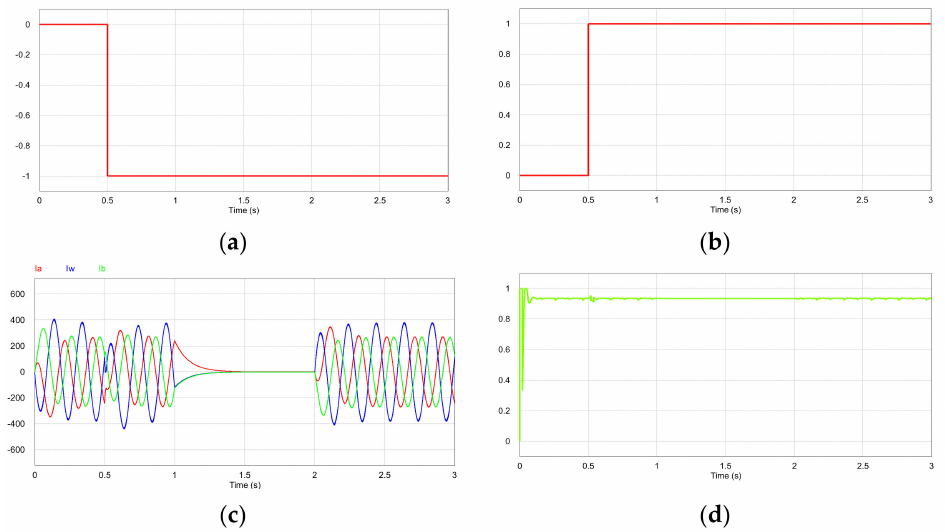
Figure 12. Faulty V 1 and V 4 at t = 0.5 s. ( a ) faulty signal of V 1 ; ( b ) faulty signal of V 2 ; ( c ) Output currents; ( d ) power